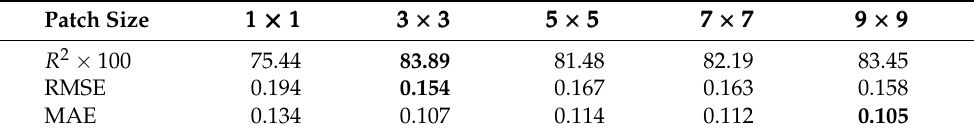
Table 4. Chl-a estimation levels of the proposed multitask model across 10-fold cross-validation with various patch sizes, with the best results in bold, where R 2 , MAE, and RMSE denote coefficient of determination, mean absolute error, and root mean square error, respectively (number of shared layers =